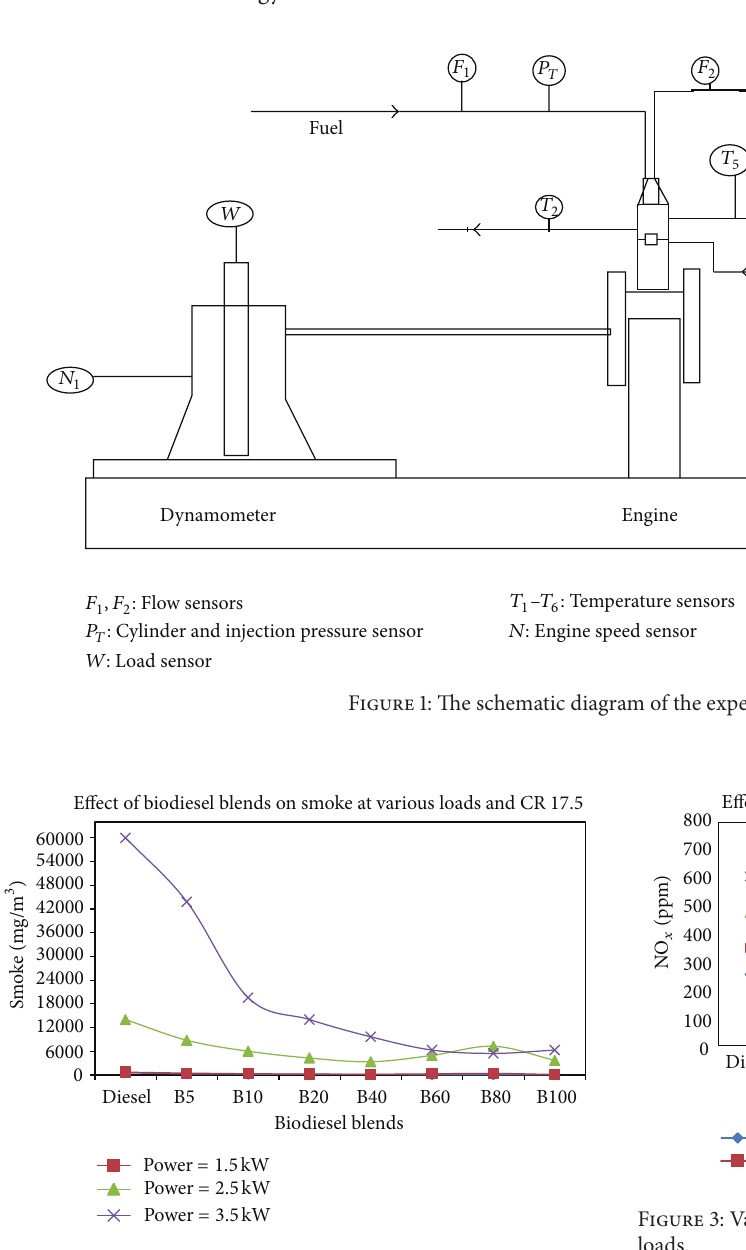
Figure 2: Variation in smoke opacity for various biodiesel blends at different loads.